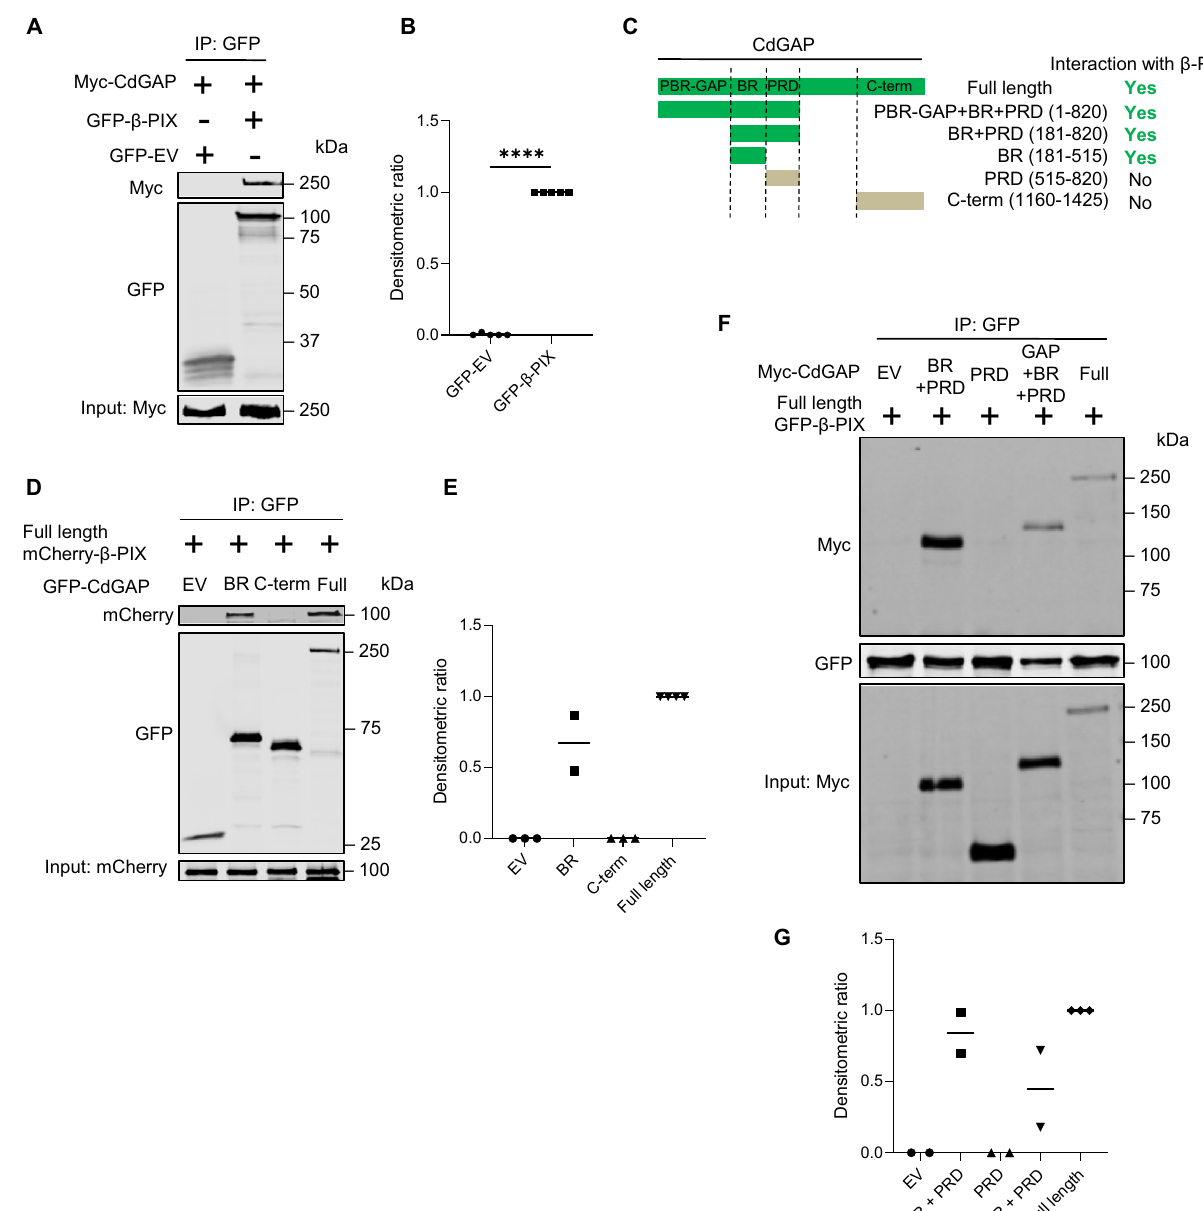
Figure 3. β-PIX interacts with the basic region of CdGAP. ( A ) HEK293 cells overexpressing myc-CdGAP and GFP-β-PIX were lysed and cell lysates were immunoprecipitated with anti-GFP antibody (for β-PIX) followed by immunoblotting for myc (for CdGAP). A representative immunoblot is shown. ( B ) Densitometric quantification of IP: normalized to total expression of myc-CdGAP in ( A ). ( C ) Schematic representation of the CdGAP deletion mutants, which were used in the co-immunoprecipitation experiments. ( D ) Cell lysates of HEK293 cells overexpressing GFP-CdGAP deletion proteins and full-length mCherry-β-PIX were immunoprecipitated with anti-GFP antibody (for CdGAP) followed by immunoblotting for mCherry (for β-PIX). ( E ) Densitometric quantification of IP: normalized to total mCherry-β-PIX expression in ( D ). ( F ) Cell lysates of HEK293 cells overexpressing myc-CdGAP deletion proteins and full-length GFP-β-PIX were immunoprecipitated with anti-GFP antibody (for β-PIX) followed by immunoblotting for myc (for CdGAP). ( G ) Densitometric quantification of IP: normalized to total myc-CdGAP expression in ( F ). n = 5 ( B ); 2–4 ( E ), 2–3 ( C ). Statistically significant differences (**** P < 0.0001), assessed by the Student’s t-test test ( B ), are indicated. EV: Empty vector; BR: basic-rich; PRD: proline-rich domain; C-term: